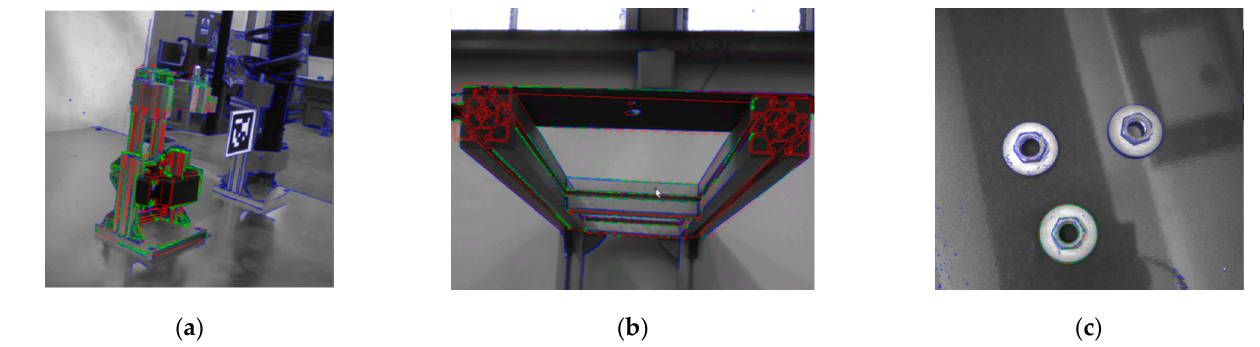
Table 2. Views of the case study processes .